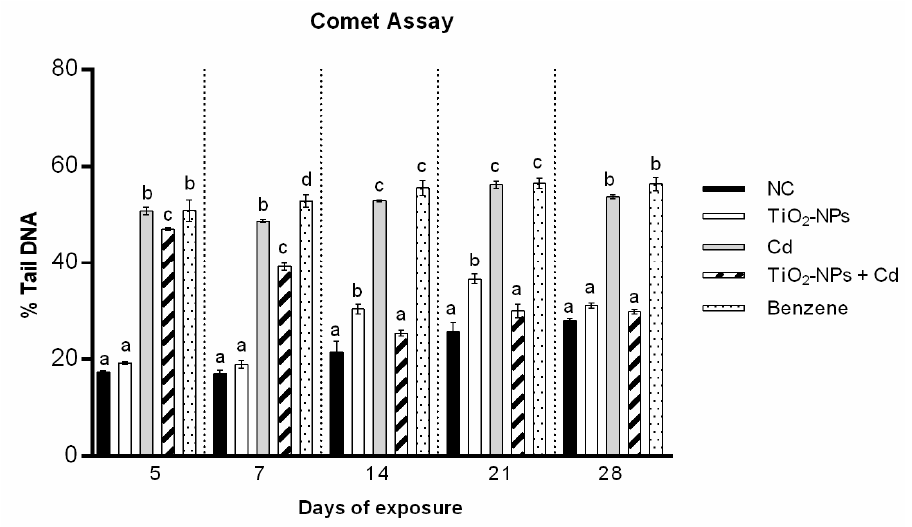
Figure 2. Percentage of DNA in the comet tail (ordinate) in zebrafish blood cells ( n = 150) after different exposure times (abscissa) to TiO 2 -NPs, Cd and to TiO 2 -NPs + Cd co-exposure. The black bars are negative controls (NC); the white bars are 10 µ g/L TiO 2 -NPs; the grey bars are 1 mg/L Cd; the striped bars are 10 µ g/L TiO 2 -NPs + 1 mg/L Cd co-treated zebrafish. The dotted bars are positive controls (benzene 10 µ L/mL). Different letters correspond to diverse statistical significances (ANOVA)* p ≤ 0.05.